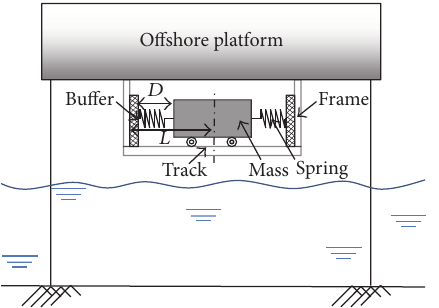
Figure 2: Schematic of a jack-up offshore platform with a bufferable TMD.